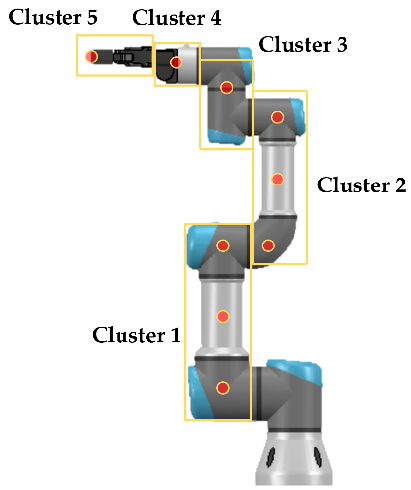
Figure 6. Points and clusters considered on the UR3 robot.